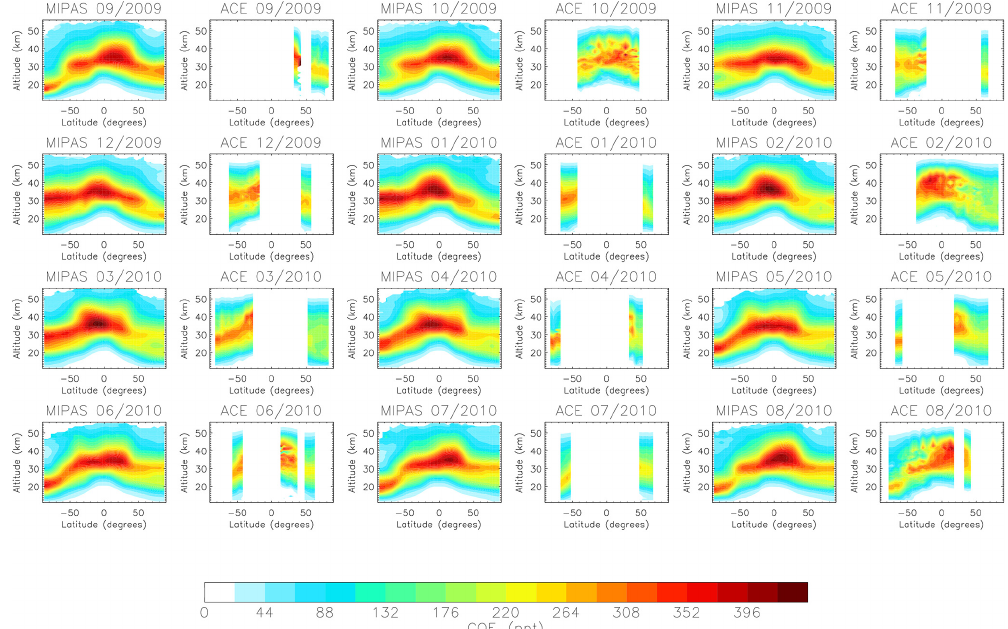
Figure 8. MIPAS and ACE zonal means between September 2009 and August 2010. The plotted VMRs are the averages for each month of all filtered data at each altitude within 5 ◦ latitude bins. Note that the global coverage of the ACE-FTS observations between September 2009 and August 2010 is poorer and noisier in appearance than MIPAS. A full discussion of the seasonal variation in the COF 2 distribution is provided in the